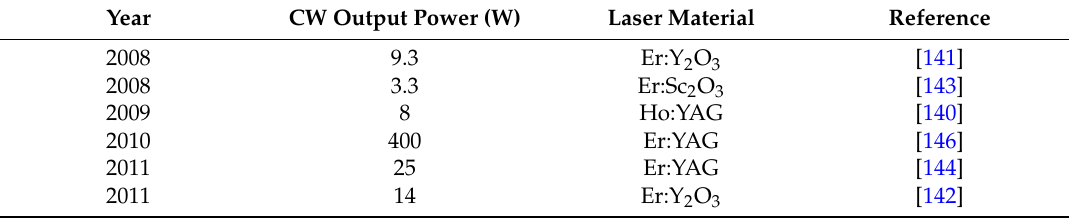
Figure 45. CW and QCW output powers from Er (blue) and Ho:YAG (red) cryogenic lasers from 2008 through 2011. Table 8. Reported Cryogenic CW Er and Ho Demonstrations From 2005–2011.